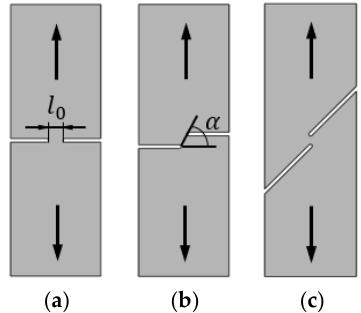
Figure 2. Schematic representation of ( a ) a double edge notched tensile test (DNTT) specimen [12], ( b ) a staggered DNTT specimen [13], and ( c ) a double notched shear test specimen [9].